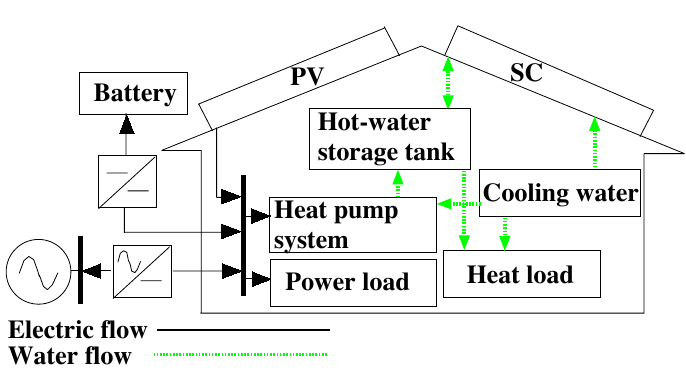
Figure 1. DC Smart house model.